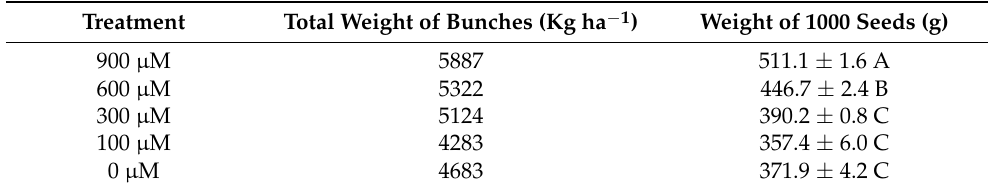
Table 1. Weight of bunches and 1000 seeds of Ricinus communis plants treated with different concen- trations of SA.